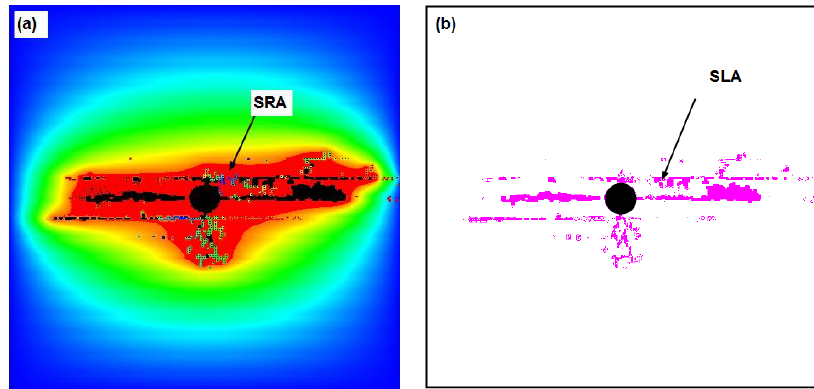
Figure 5. Determination of SRA and SLA based on gray segmentation for case 14: ( a ) color shadow indicate relative magnitude of the pore water pressure field, andSRA is the overall reflection of hydraulic fracturing effectiveness, it corresponds to the red region; and ( b ) SLA reflects the hydraulic fracturing effectiveness of silty laminae, it corresponds to the black region in ( a ).